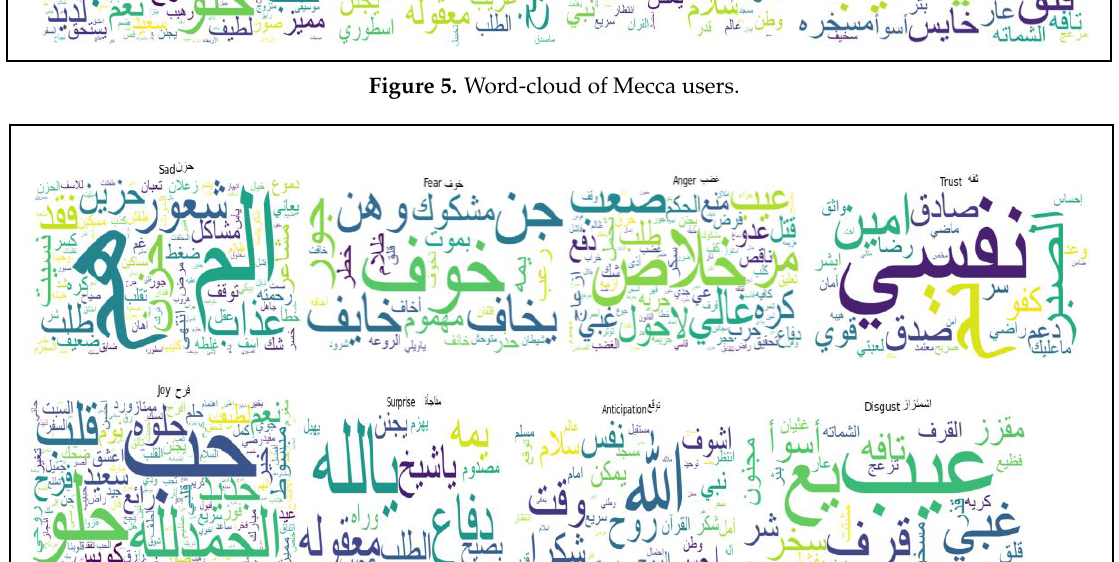
Figure 6. Word-cloud of Riyadh users.